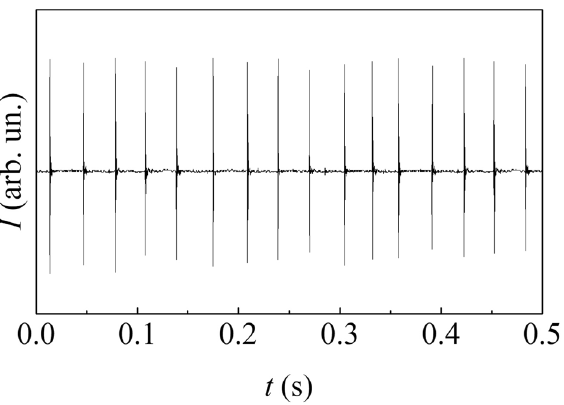
Figure 3. The intensity, I , of signals generated by the piezoelectric sensor as a function of time, t . Data refer to a BM experiment carried out swinging the reactor at 14.6